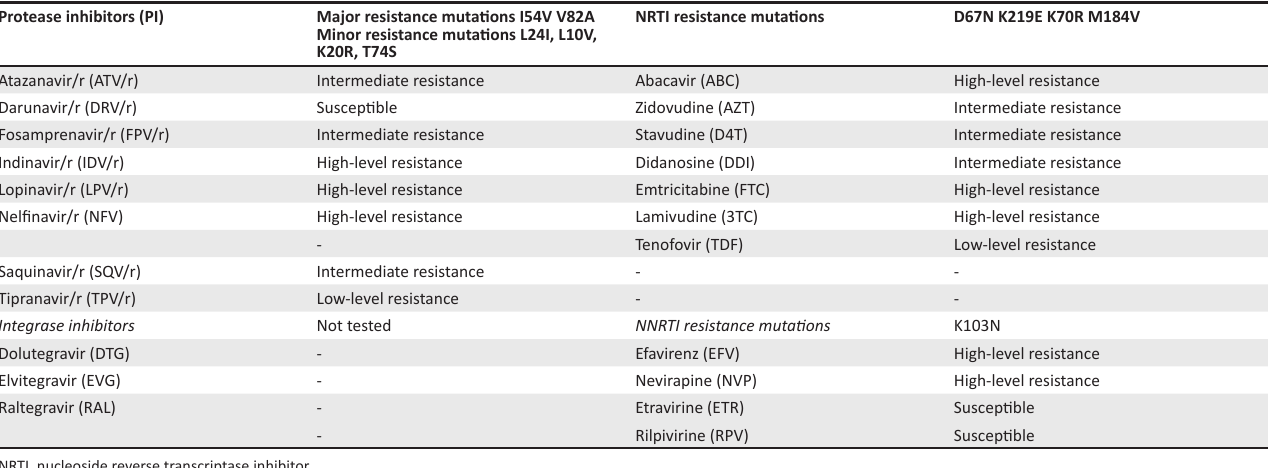
TABLE 1: Resistance patterns for the patient (multiple-choice question scenario). Protease inhibitors (PI)